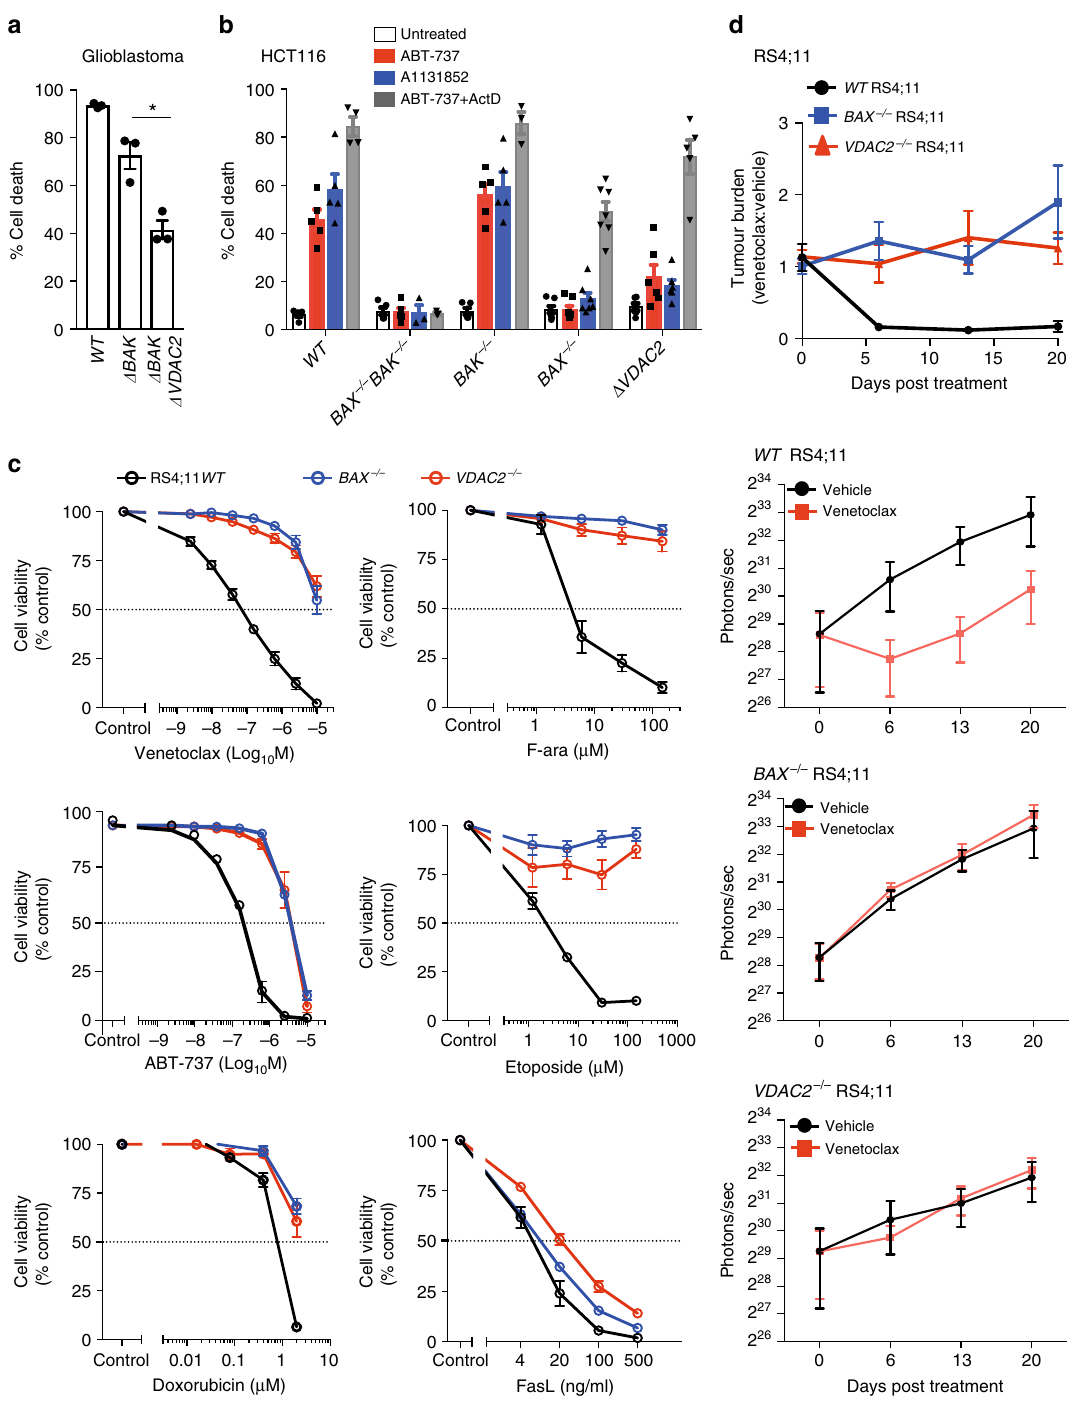
Fig. 5 VDAC2 enables BAX-mediated killing of cancer cells in vitro and in vivo. a Deletion of VDAC2 inhibits BAX-mediated apoptosis in glioblastoma cells. Glioblastoma cells (U-251) were treated with ABT-737 (1 μ M) and S63845 (1 μ M) and cell death assessed after 24 h. Data are mean + / − SEM of three independent experiments. * p < 0.05 based on Student ’ s unpaired t -test. b Deletion of VDAC2 protects HCT116 colorectal cancer cells from apoptosis. HCT116 cells were treated with ABT-737 (5 μ M), A1331852 (5 μ M) or ABT-737 (5 μ M) + actinomycin D (1 μ M) for 24h and cell death assessed. Data are mean + / − SEM of fi ve independent experiments. c BAX or VDAC2 deletion renders RS4;11 acute lymphoblastic leukemia cells resistant to venetoclax or other chemotherapeutic agents. WT, BAX − / − or VDAC2 − / − RS4;11 cells were treated with venetoclax, ABT-737 and standard-of-care chemotherapies (F-ara, etoposide, doxorubicin) or the BAX/BAK-independent stimulus Fas ligand (FasL) and cell viability assessed by PI exclusion. Data are mean + / − SEM of at least 3 independent experiments. d Deletion of VDAC2 renders RS4;11 cells resistant to venetoclax in vivo. RS4;11 cells were subcutaneously engrafted into NOD/SCID/IL-2R γ null mice, treated with venetoclax and tumor growth monitored by IVIS imaging. The collated data (top panel) is normalized to represent relative tumor burden. Data are mean + / − SEM collated from four independent experiments, N = 12 mice engrafted with each genotype of RS4;11